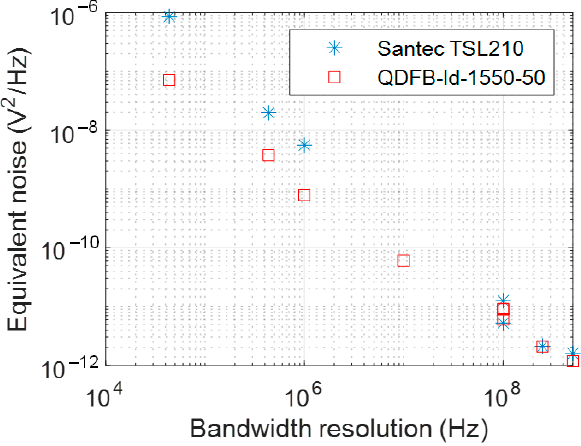
Figure 12. Equivalent noise as a function of the bandwidth resolution for both lasers.